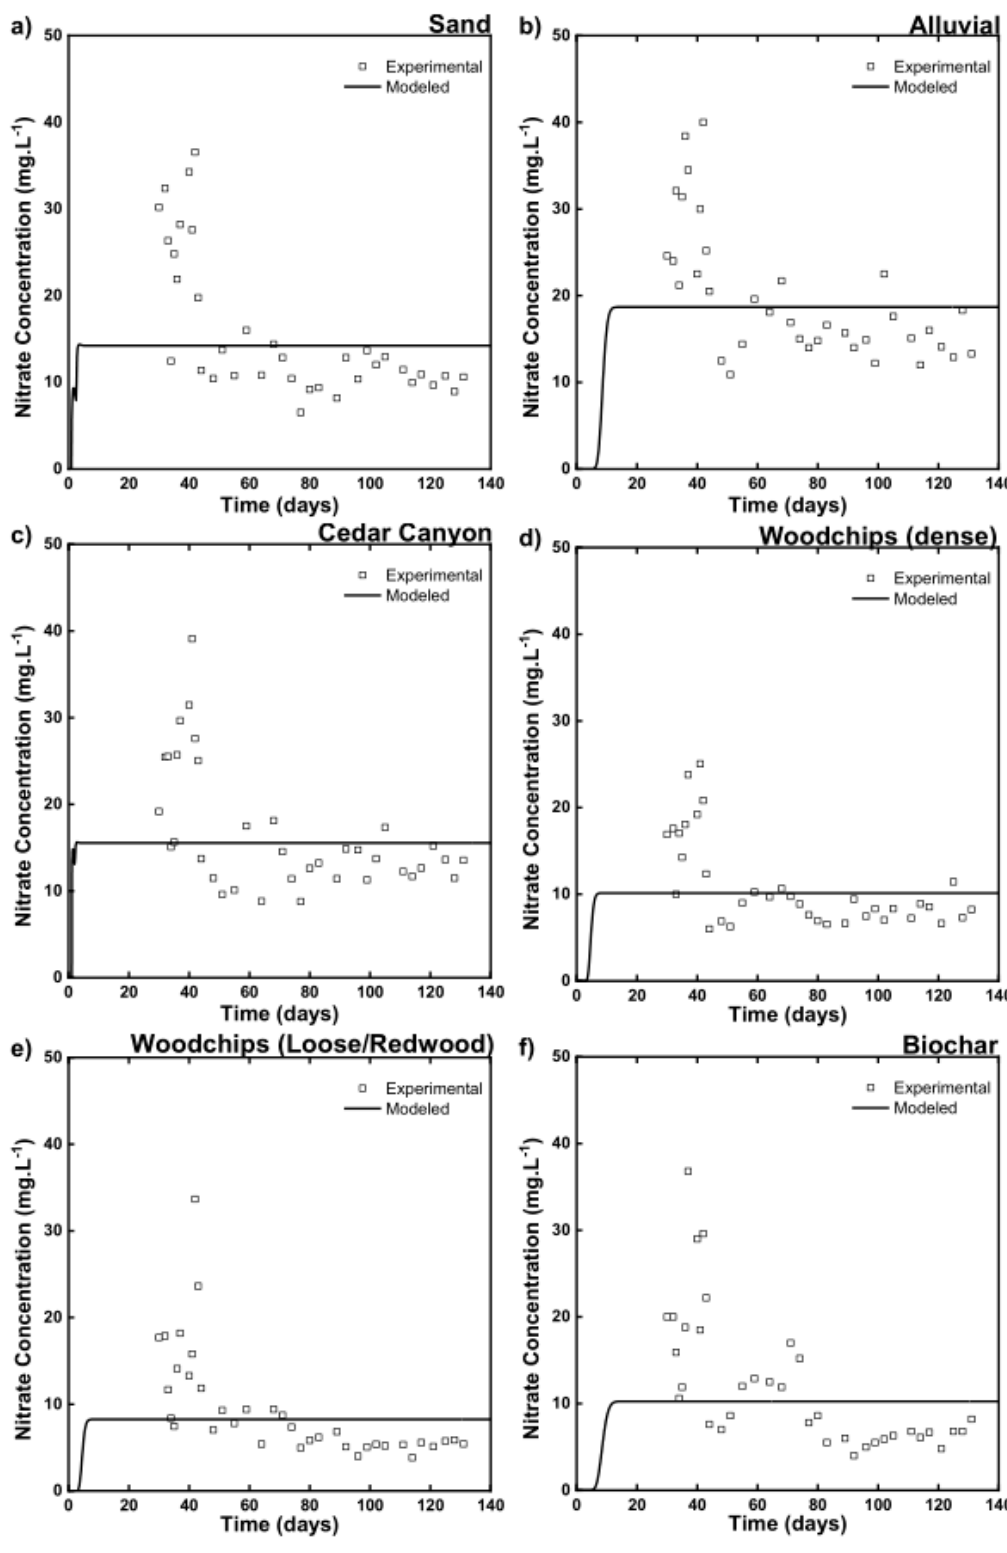
Figure 4. Calibrated Nitrate Concentration for ( a ) Sand, ( b ) Alluvial, ( c ) Cedar Canyon, ( d ) Woodchips (dense), ( e ) Woodchips (Loose), and ( f ) Biochar.